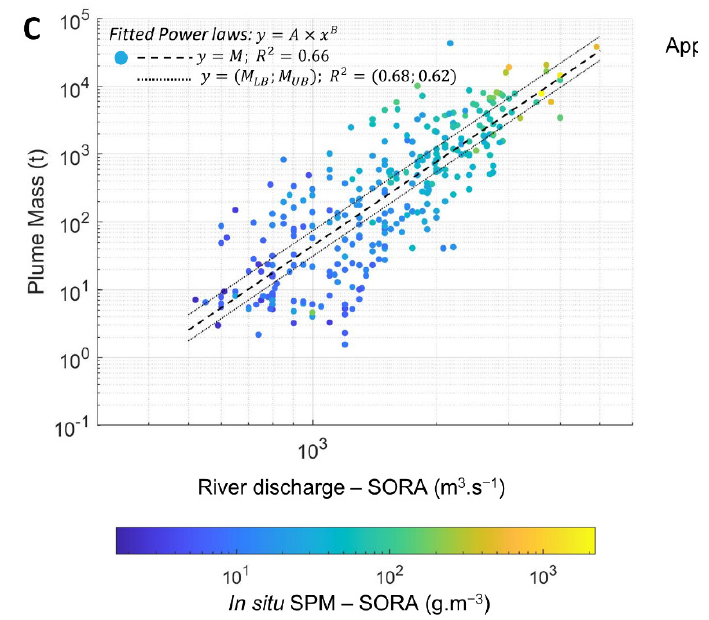
Figure 10. Relationships between the Rhône River discharge measured at SORA and ( A ) the SPM concentrations measured at the SORA station (SPM S , red points) and estimated at the MesuRho platform (SPM M , blue points), ( B ) the Rhône River plume surface (S), and ( C ) the Rhône River plume SPM mass (M). The SPM concentration at the MesuRho platform as well as the Rhône River plume surface and SPM mass were estimated using MODIS data (2014, 2015, 2016, 2018). Fitted relationships are represented with dashed lines and coefficients are given in Table 4. Two power laws were fitted to the river discharge vs. SPM concentration relationships, one for river discharges ranging from 500 to 3000 m 3 .s − 1 and the other one for river discharges larger than 3000 g.m − 3 . Dotted lines on B and C represent the fitted relationships for plume surface and SPM mass obtained with a plume boundaries threshold of 2 g.m − 3 and 4 g.m − 3 and thus represent the plume surface and mass upper (UB) and lower bounds (LB), respectively. All relationship coefficients are given in Table 4.